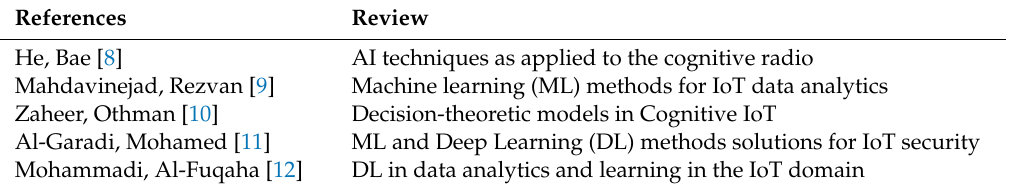
Table 1. Summary of related works .